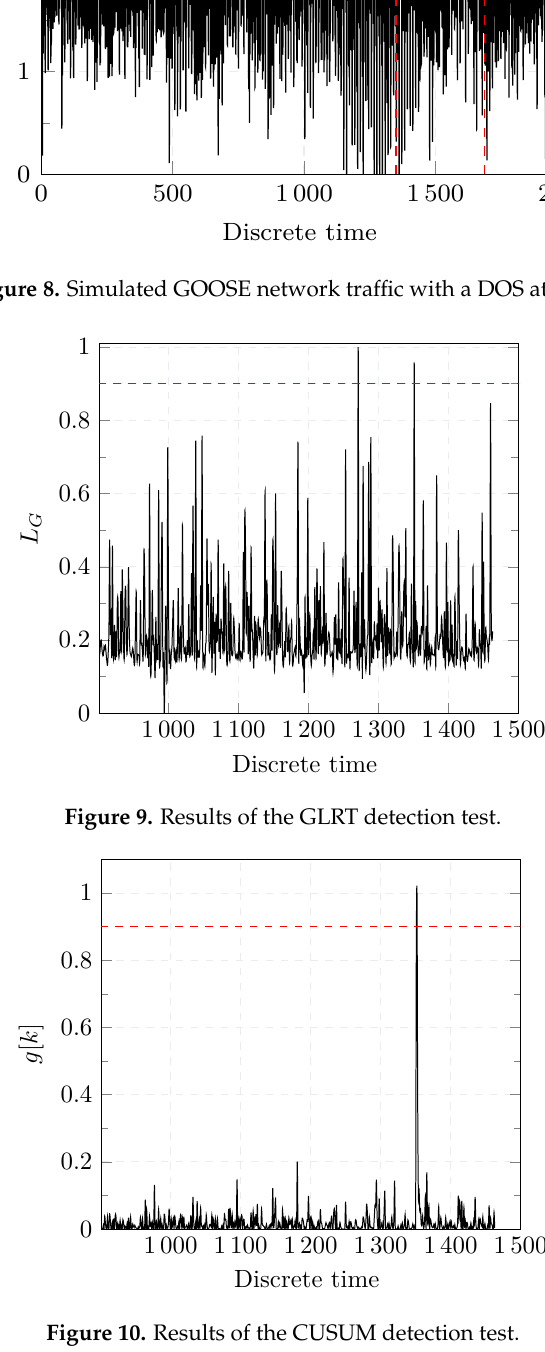
Figure 10. Results of the CUSUM detection